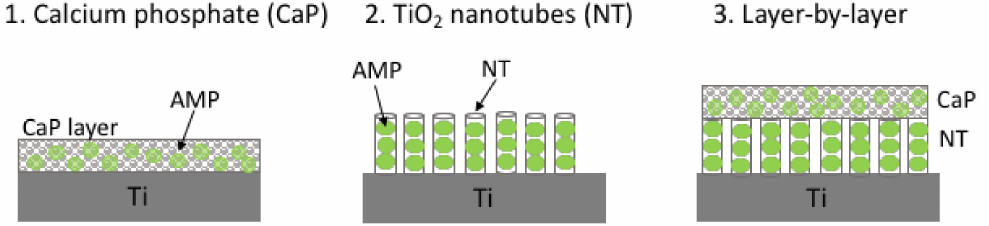
Figure 4. AMP release coating strategies on titanium surfaces. CaP: calcium phosphate coating; NT: TiO 2